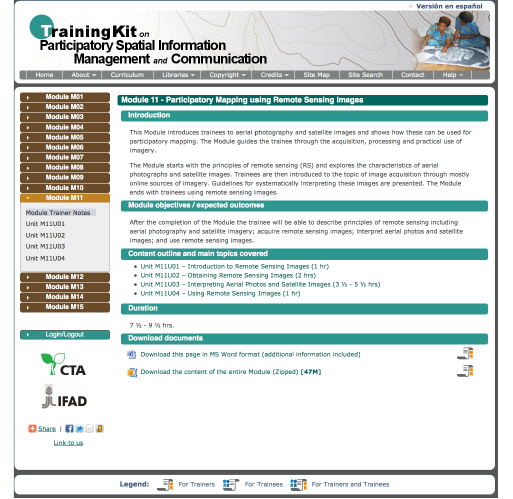
Figure 7: Lecture on Airborne Data Acquisition including annotations http://pgis-tk-en.cta.int/